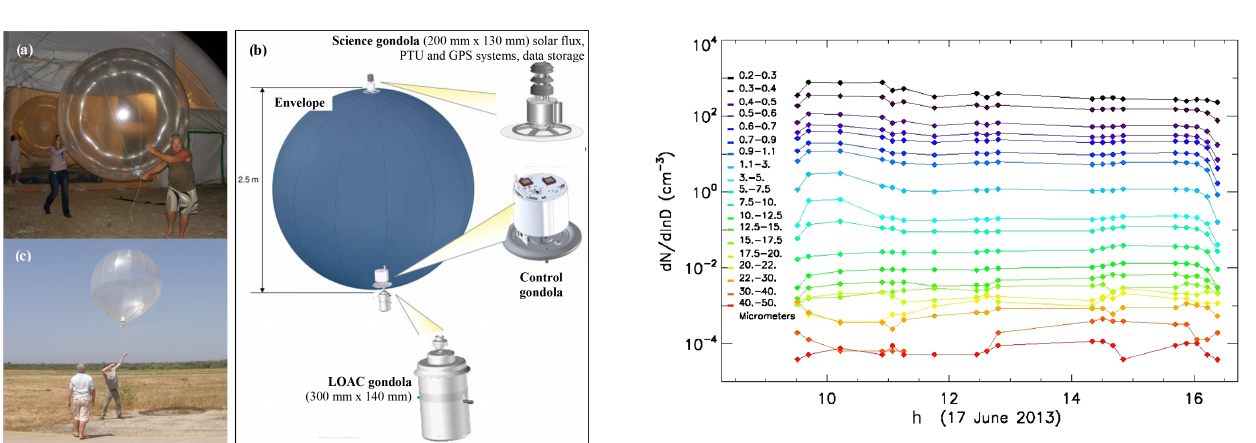
Figure 11. (a) CNES 2.5m tropospheric pressurized balloon shortly before a night launch; (b) scheme of the pressurized balloon and gondolas; the scientific and control gondolas communicate by radio; (c) launch of balloon from Minorca on 17 June 2013, 9:45UT.